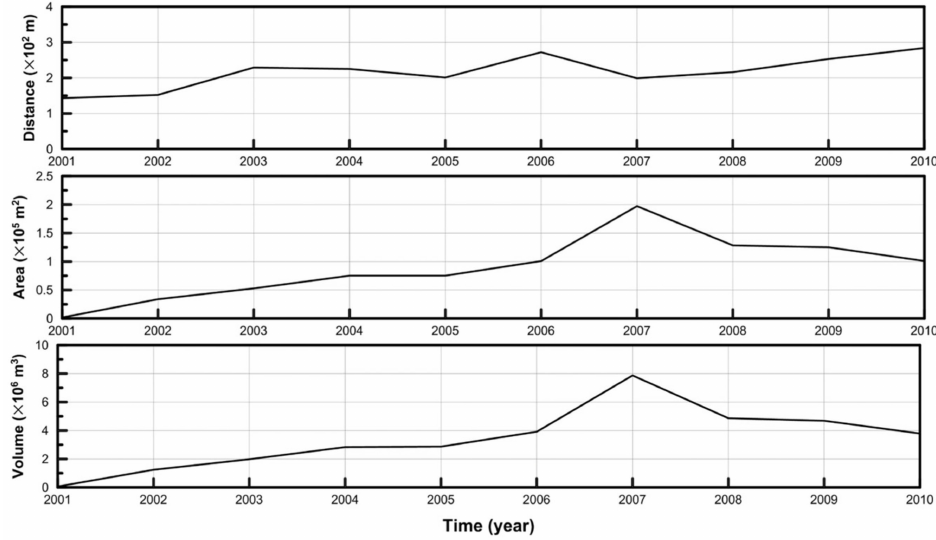
Figure 9. The scour area, volume, and depth of the − 35 m scour hole.